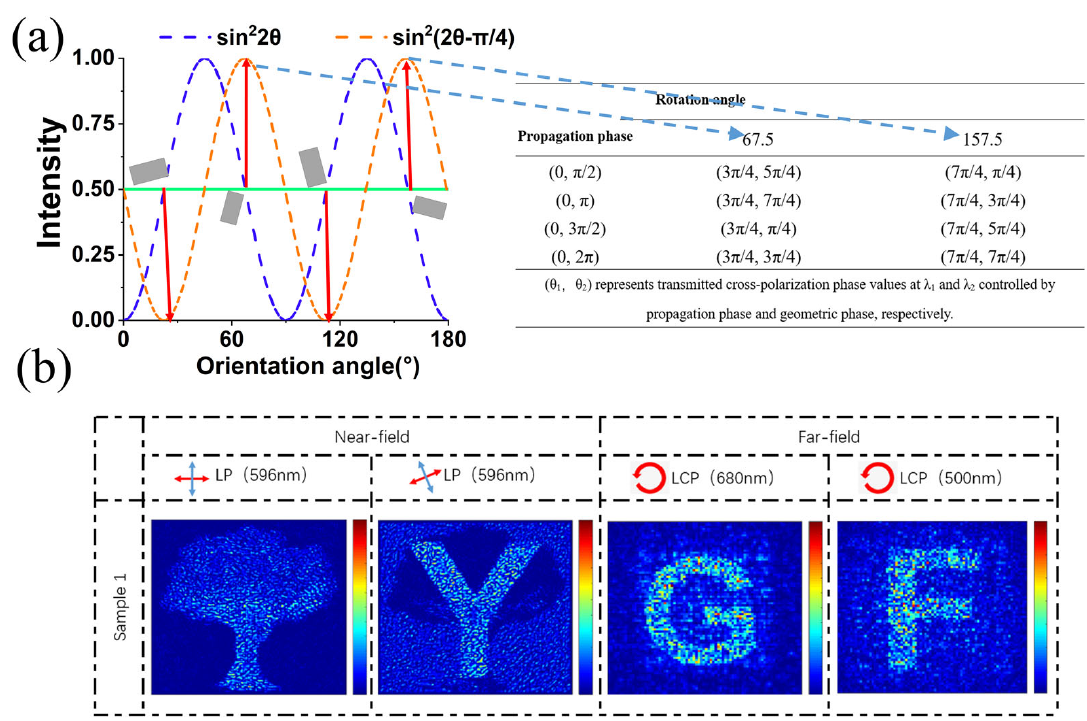
Figure 9. ( a ) Schematic diagram of the binary image encoding besides the three channels. Take the gray value of 0.5 as an example, four candidate orientation angles are obtained. If the corresponding pixel in the binary image is high level, the orientation of 67.5° and 157.5° can be chosen and 4 × 2 phase groups are listed. Select the most suitable phase group to realize dual-wavelength holography. ( b ) The simulation results of the four ‐ channel holographic and nanoprinting images.